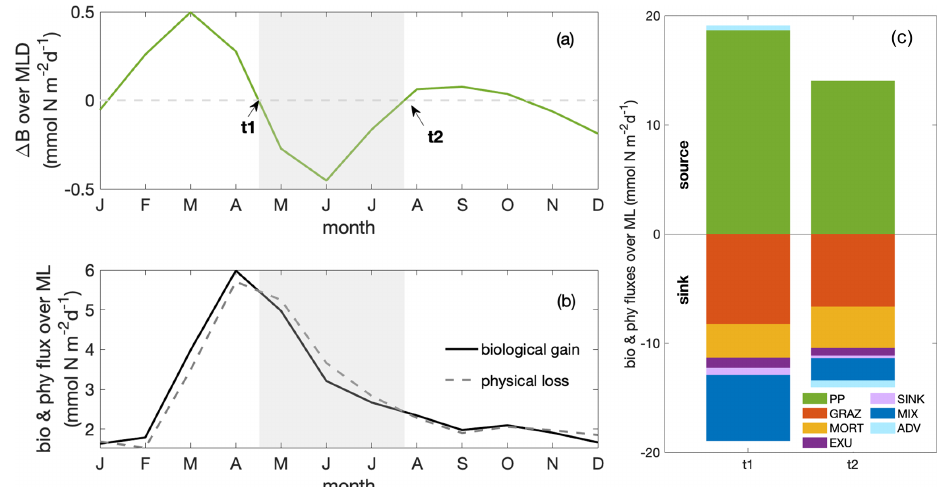
Figure 4. Seasonal cycles of (a) total phytoplankton biomass change ( (cid:49)B ; in mmolNm − 2 d − 1 ). Grey shading indicates the decline phase, with t 1 and t 2 marking the beginning and end of the decline phase. (b) Phytoplankton fluxes resulting from net biological gain (bio) and net physical loss (phy; in mmolNm − 2 d − 1 , as shown in Eq. 1); (c) balancing budgets of phytoplankton fluxes at t 1 and t 2 (PP: primary production; GRAZ: consumptive mortality; MORT: natural mortality; EXU: exudation; SINK: sinking; MIX: mixing; ADV: advection). Fluxes are distinguished as sources (positive values) and sinks (negative values) of phytoplankton biomass, with the sum of all source and sink terms balancing at times t 1 and t 2 . All fluxes are integrated over the